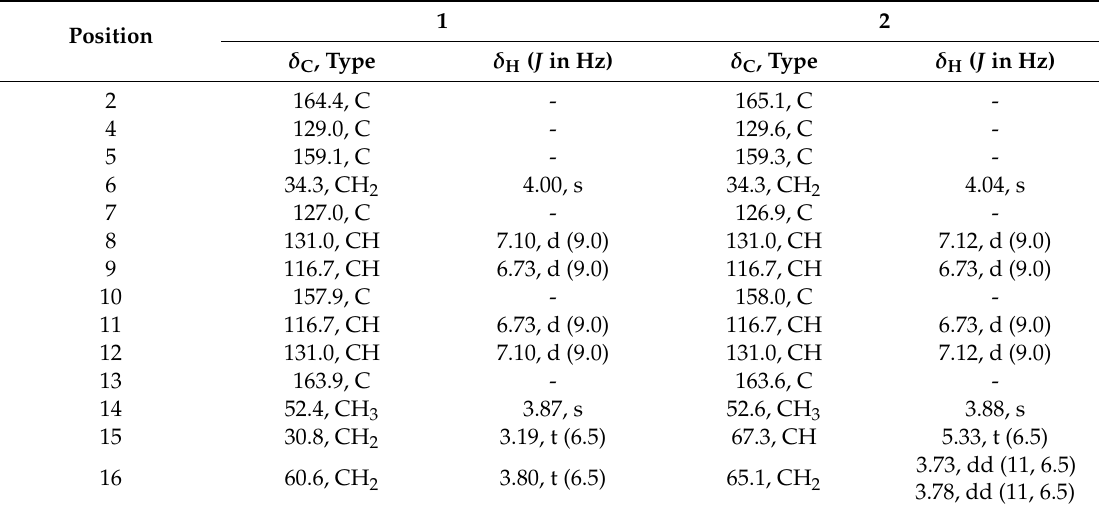
Table 2. 13 C and 1 H-NMR spectroscopic data ( 1 H 500 MH Z , 13 C 125 MH Z in Methanol- d 4 , δ in ppm) for compounds 1 and 2